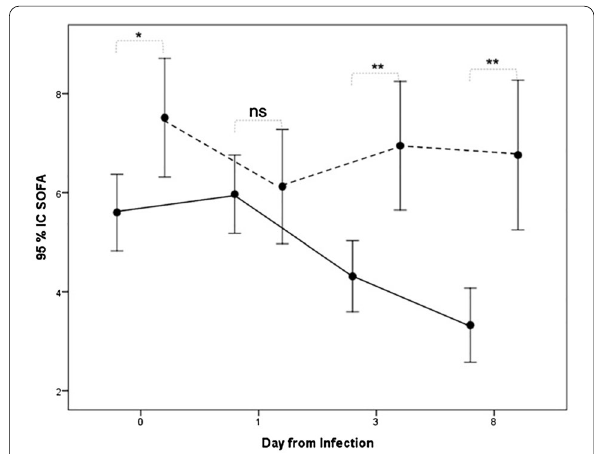
Fig. 1 Evolution of SOFA score between the two groups, failure and clinical success, from wtAE infection and as a function of time. The dotted line represents the clinical failure group and the solid line represents the clinical success group. * p < 0.02, ** ≤